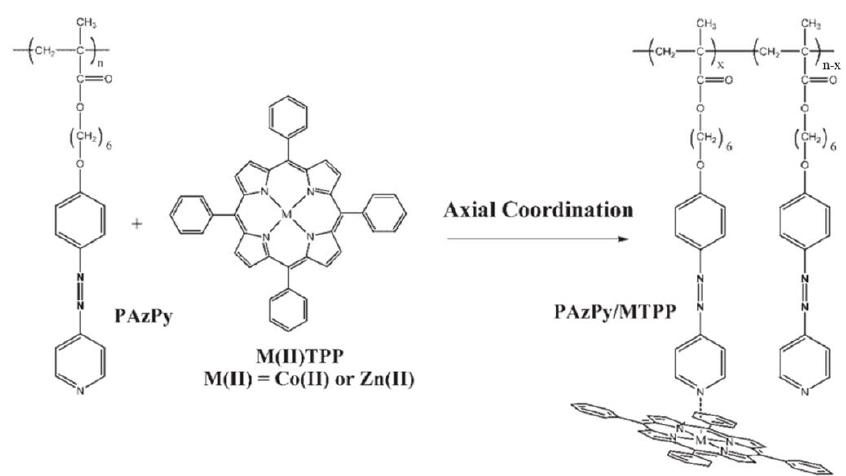
Figure 19. Complexation via axial coordination between PAzPy and ZnTPP or CoTPP. Reprinted with permission from [106]. Copyright 2006, Wiley.